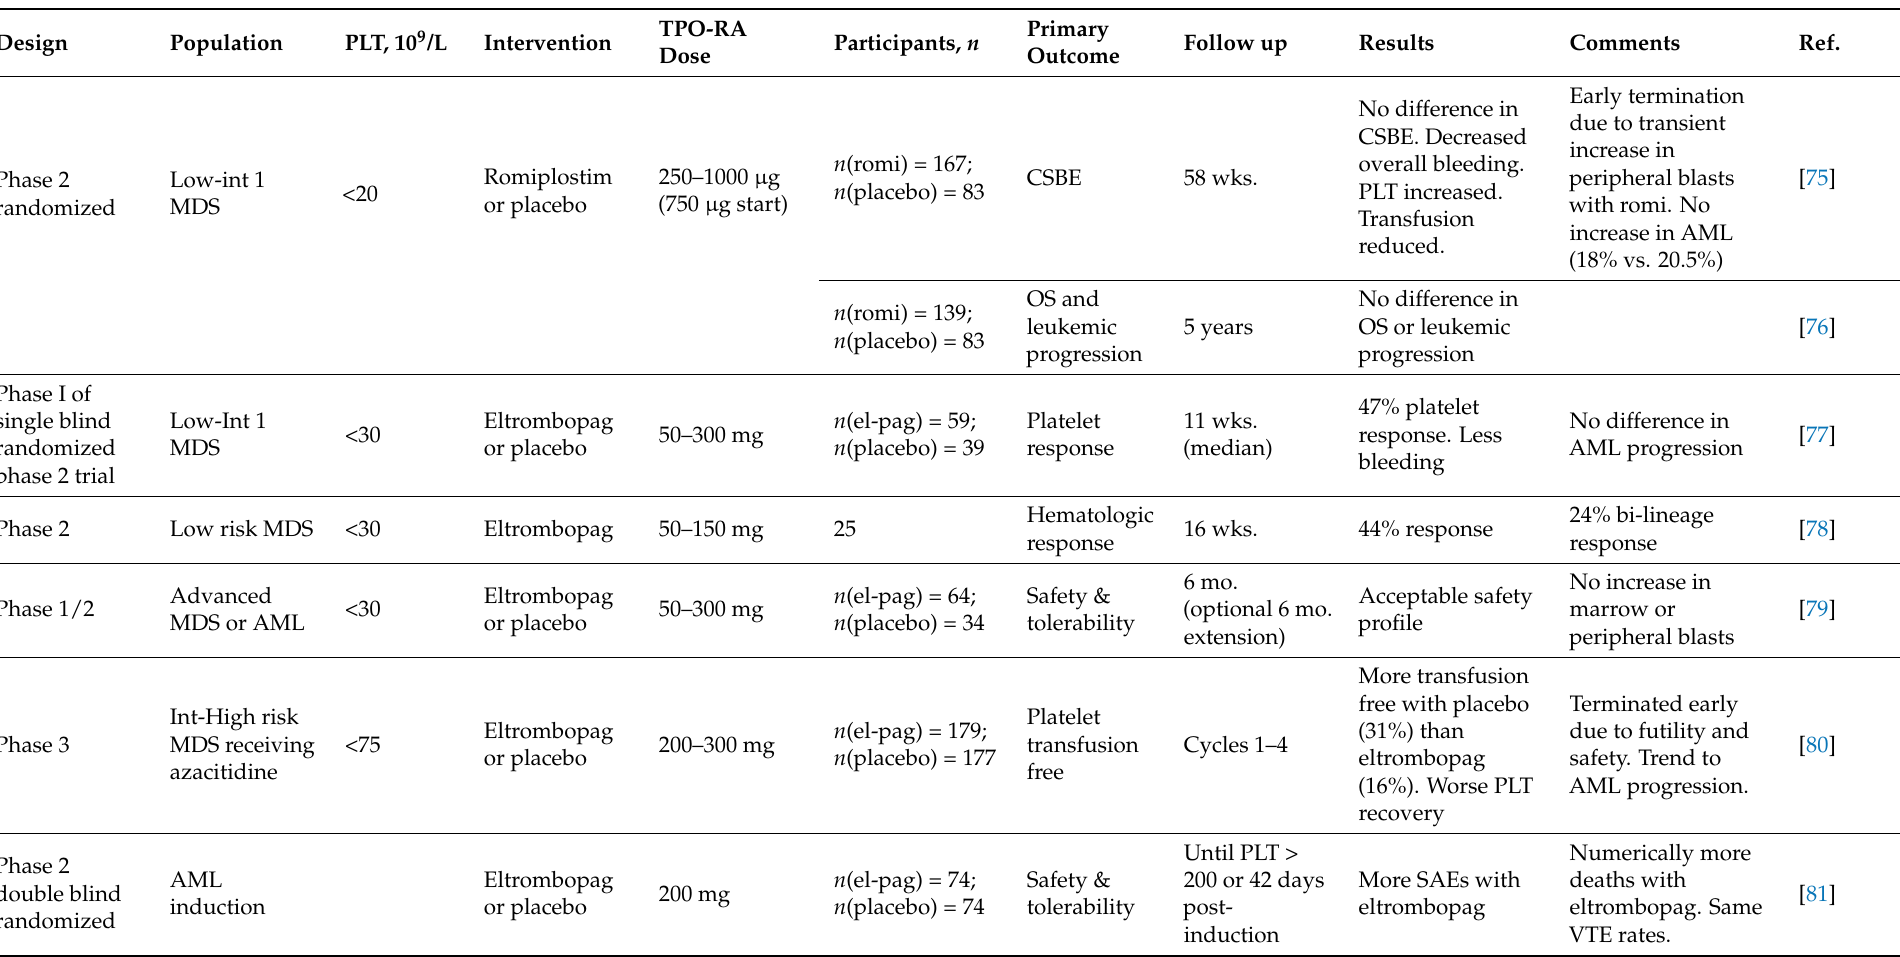
Table 2. Summary of studies on TPO-RAs in MDS and